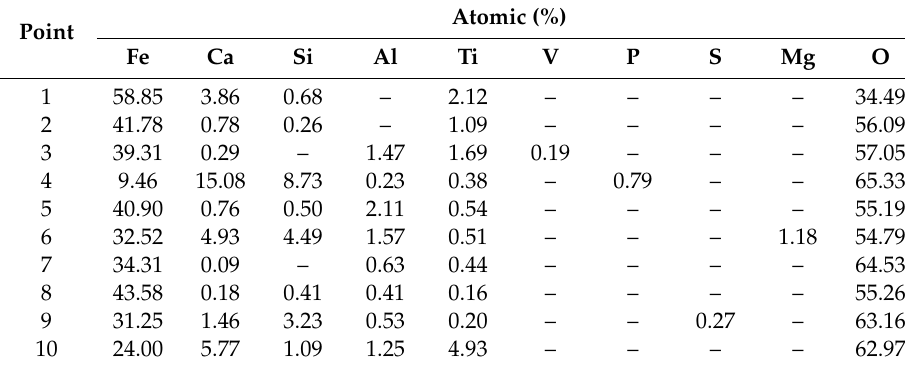
Table 7. EDS analysis for sinter Blend 2 sintered at 1473